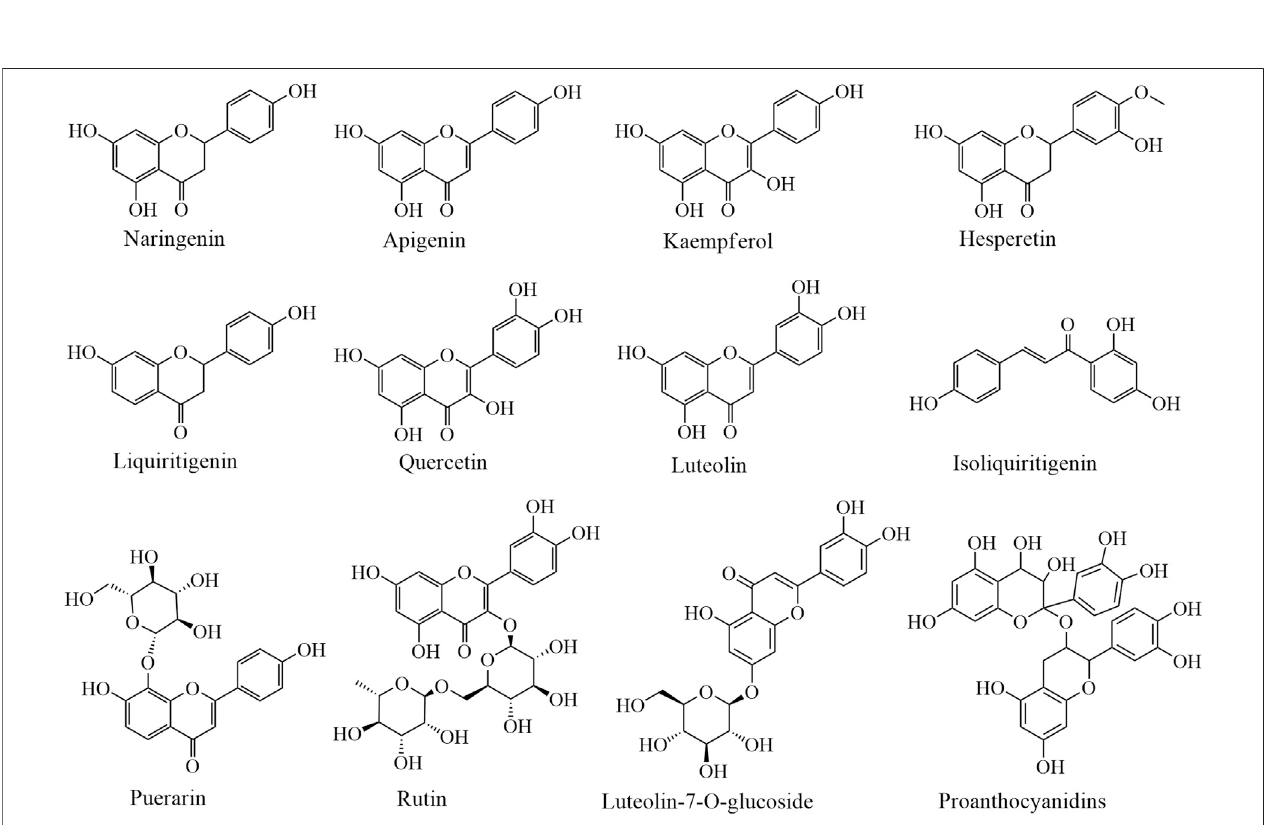
FIGURE 3 | The immune enhancement effects of fl avonoids in plant-based functional